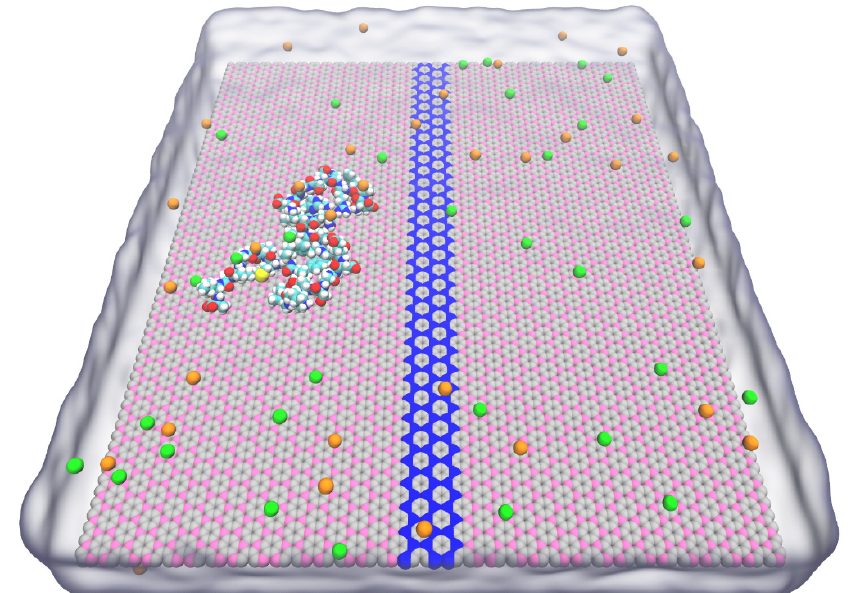
Figure 1. The initial simulation configuration of the A β 1–42 peptide on the BC 3 /C 3 N/BC 3 heterostructure. Carbon, boron, and nitrogen atoms in the 2D material are colored in silver, pink, and blue, respectively. Atoms in the peptide are shown as spheres (C: cyan; O: red; H: white; N: blue; and S: yellow). K + and Cl − ions are colored in green and orange, while water molecules are shown as glass bubbles.